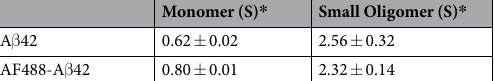
Table 1. Experimentally determined sedimentation coefficients for A β 42 monomer and small oligomer. * Sedimentation coefficients for the monomeric and small oligomeric species of A β 42 were determined from c ( s